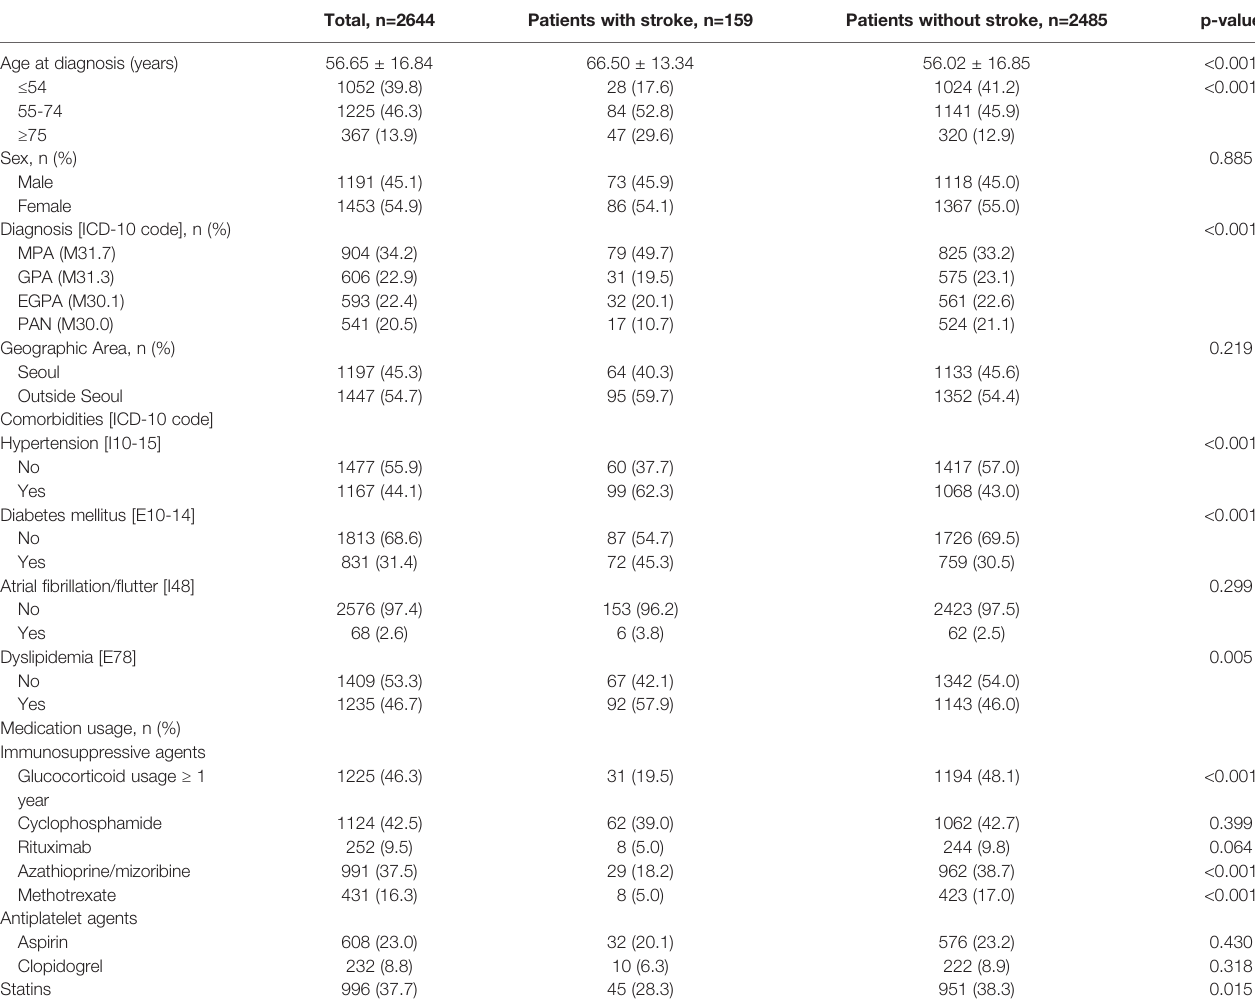
TABLE 1 | Baseline clinical characteristics of SNV patients with stroke and those without stroke. Total, n=2644 Patients with stroke, n=159 Patients without stroke,